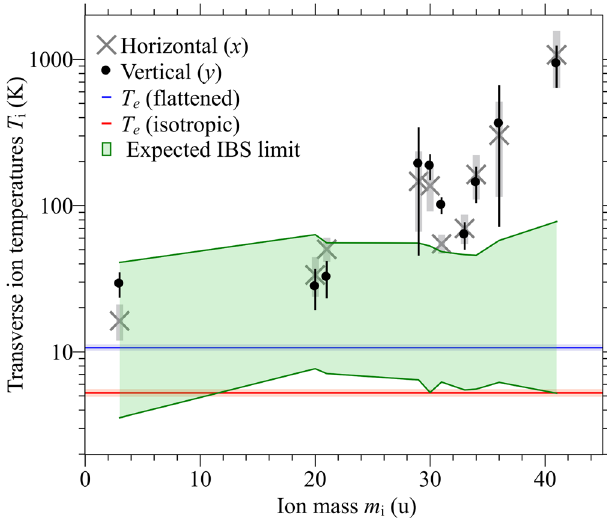
10. Horizontal and vertical transverse ion beam temper- atures after electron cooling. The colored horizontal bars indicate the best-fit electron temperatures T e corresponding to the observed cooling rates, for flat and isotropic velocity distribu- tions. The shaded green area is the expected ion temperature corresponding to the IBS limit (see